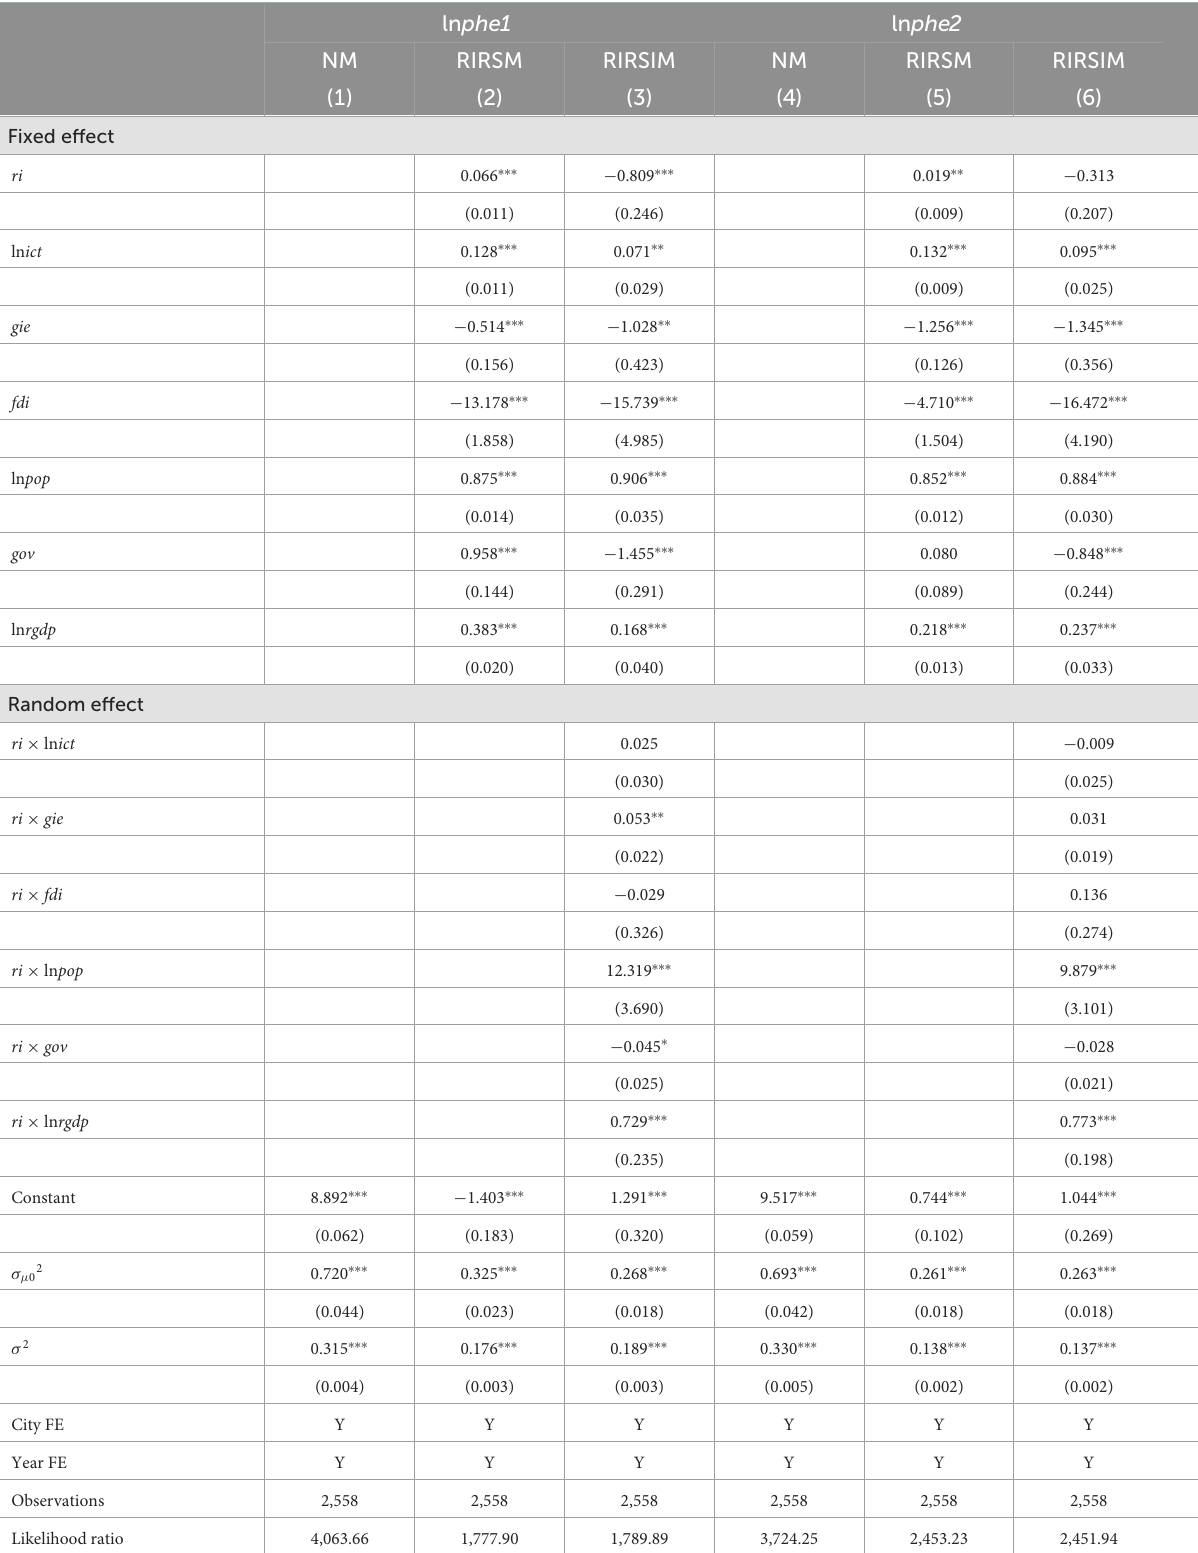
TABLE 2 Impact of regional integration on public healthcare